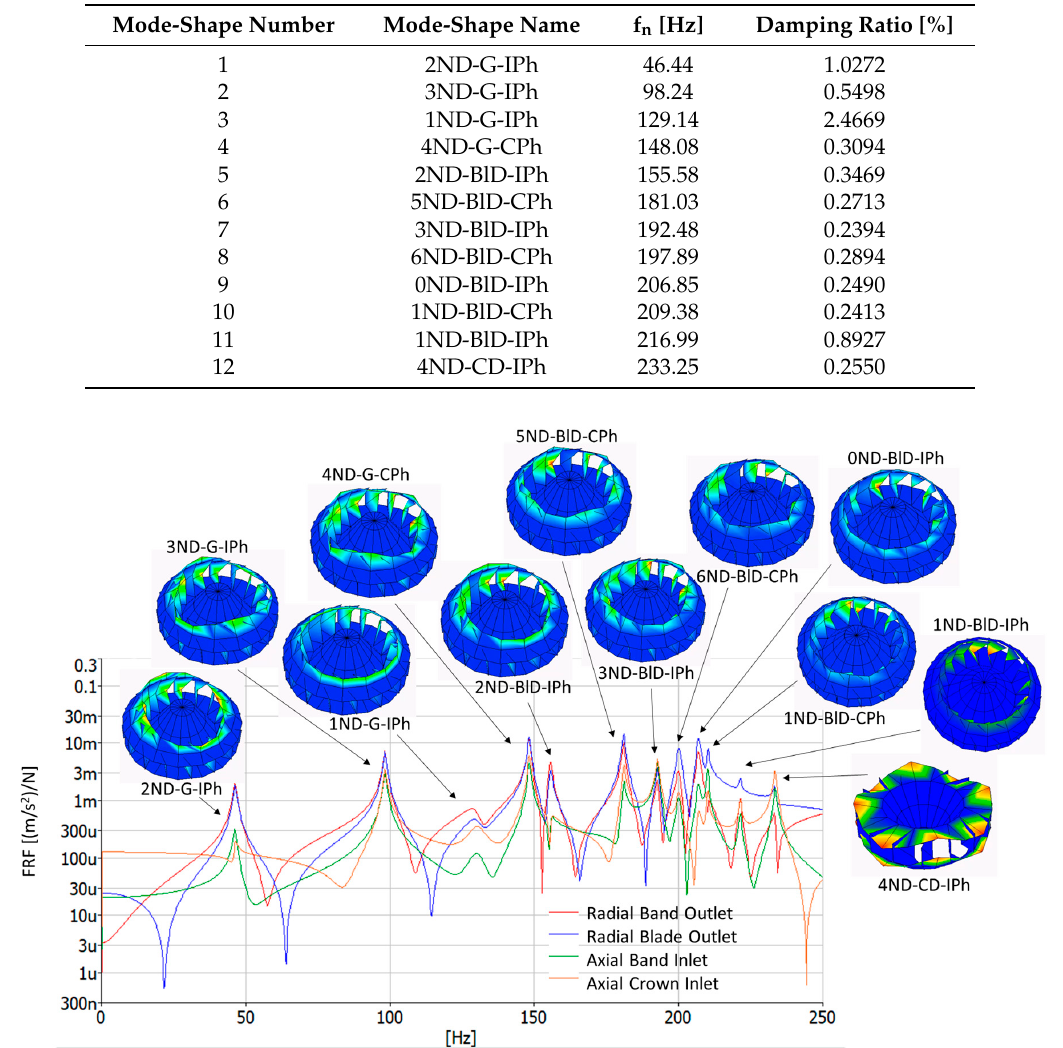
Table 2. First 12 mode shapes, natural frequencies and damping ratios of the runner in air. Results obtained by means of the EMA.